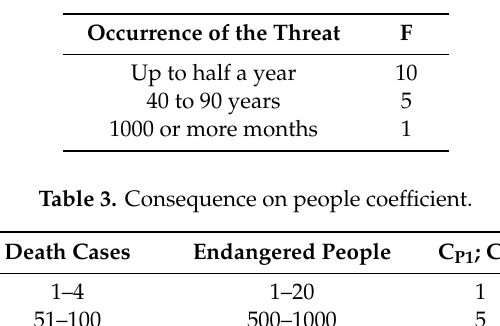
Table 2. Frequency of the threat.